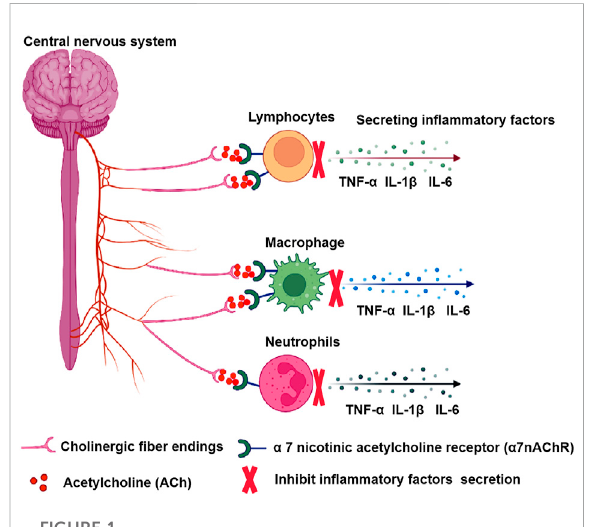
FIGURE 1 The molecular mechanisms of the CAP. The central nervous system releases ACh through efferent vagal endings and binds to α 7nAChR on various in fl ammatory cells, inhibiting the release of pro-in fl ammatory